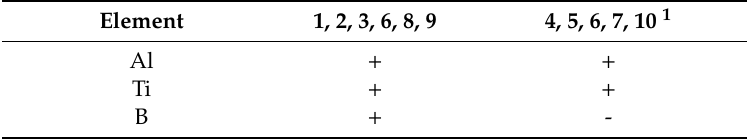
Table 6. Quantitative elemental analysis elemental analysis of SHS product.